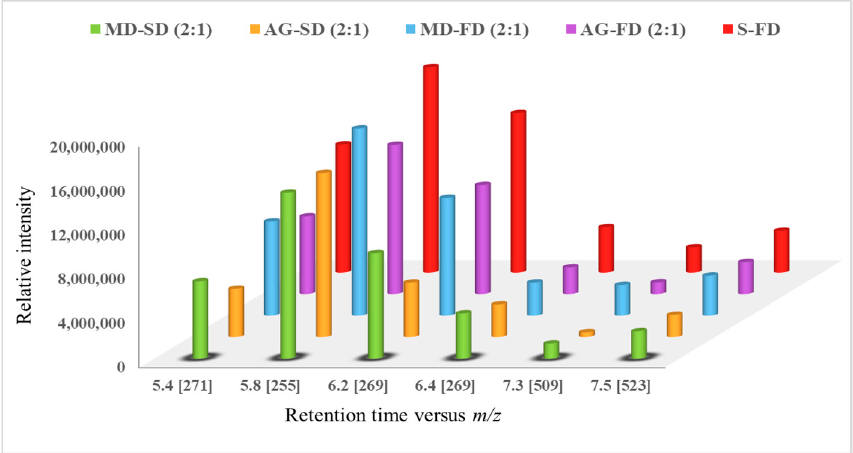
Figure 6. Comparative diagram of the relative abundances of 3-DXA present in the red dye extract non-encapsulated extracts (S-FD) and extracts encapsulated with maltodextrin (MD) and Arabic gum (AG) obtained by freeze-drying (FD) and by spray-drying (SD).